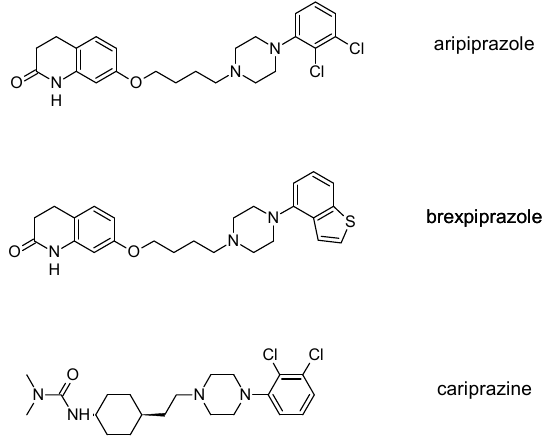
Figure 2. Antipsychotic drugs categorized as the third generation and their structures.